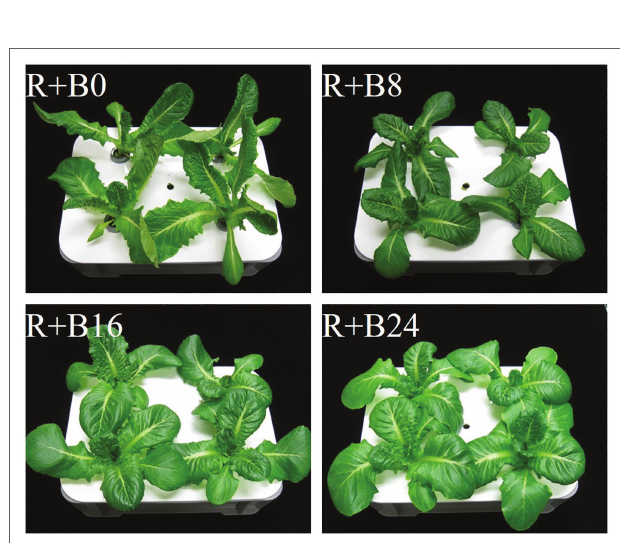
FIGURE 6 | Cos lettuce plants grown under irradiation conditions described in Figure 2 (Experiment